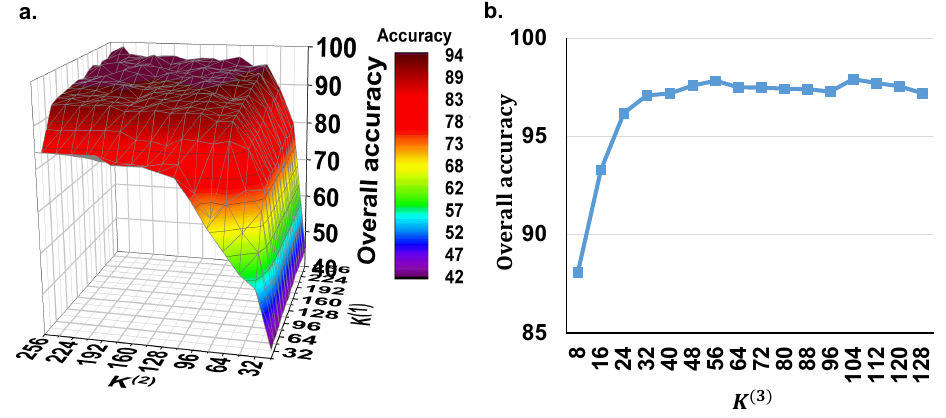
Figure 3. The model’s sensitivity to the depth of the convolutional filters. ( a ) Overall accuracy of using different K ( 1 ) and K ( 2 ) values with a fixed K ( 3 ) of 16. ( b ) Overall accuracy of using different K ( 3 ) values under the fixed K ( 1 ) and K ( 2 ) values of 128 and 64. Here, K ( 1 ) is the depth of the 1D convolutional layers for the spectral feature extraction, K ( 2 ) is the depth of the 3D convolutional layers for the spectral–spatial feature extraction, and K ( 3 ) is the number of the capsule vector